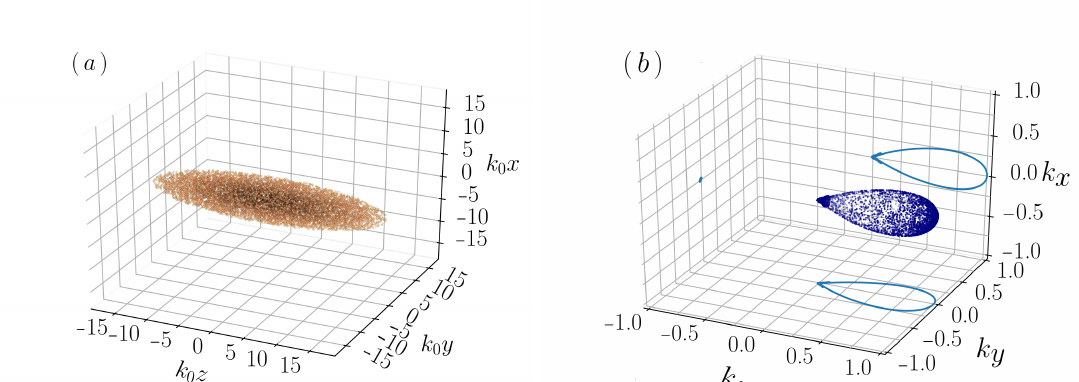
Figure 6. Initial atomic distribution, in ( a ), and bunching factor, in ( b ), of an ellipsoidal 3D atomic cloud, with N = 10 4 , irradiated with a transversely polarized pump field propagating parallel to its major axis.